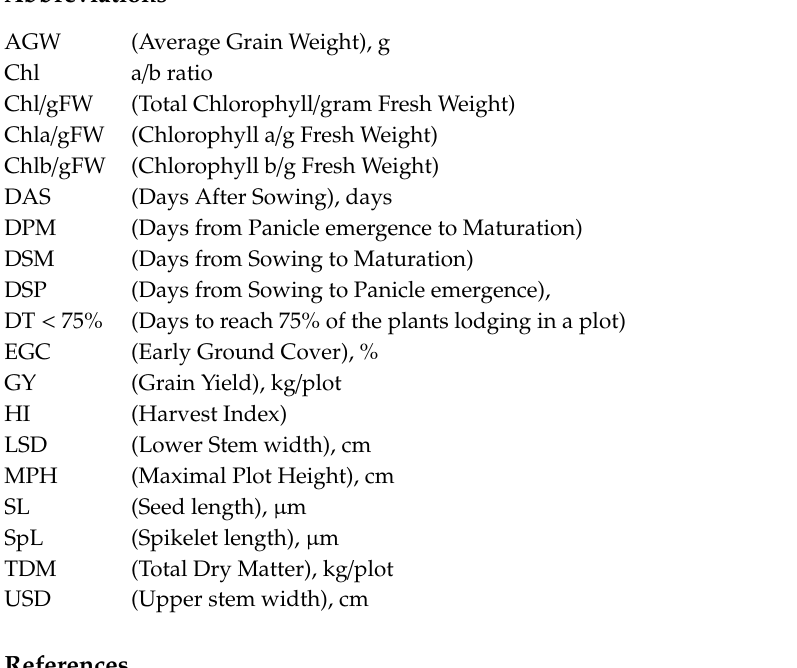
Figure S1: Two examples of te ff plants that didn’t exhibit lodging in original plot locations. From these plants, and from other plants spotted, a single spike was collected for establishing the current seed collection. Figure S2. Populations collection propagated in the greenhouse o ff season. Each population originated from a single spike was sawn in on pot. Figure S3: A field experimental plot design as well as an overview of the field at early (24 DAS) growth stages. Figure S4: Early growth cover evolution of plots in the field experiment. Images were analyzed using the Coveragetool (ref). Figure S5: Projected stem width of the first lowest node which bears one leaf (’Upper’) and, b) the most basal internode (‘Lower’, below a), measured at 70 DAS. Figure S6: As a part of the process of average grain weight (AGW) evaluation, seeds were spread over a white sheet and photographed. For each plot the image was threshold using ‘ coveragetool ’ (by sampling seeds to account) to be further processed by Image J’s particle count tool. Figure S7: (a) A general overview of the ARO filed experiment which shows the wide phenotypic variance of the genetic material. (b) A survey on one of the: a) White, b) 44A-163-B, c) 44B-163-W, and d) 53-2-2-W plots at: 63,70,77,87 days after sawing at the ARO field experiment. The dashed boxes is distinctive of the subjected plot. Figure S8: Flow diagram of Injera preparation. Figure S9: Images of Injera flat beard made from of each of the 11 populations characterized in the field experiment as well as three market